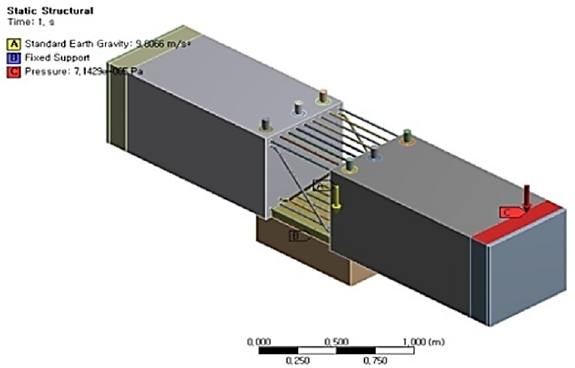
Fig. 20. Load and Boundary Conditions